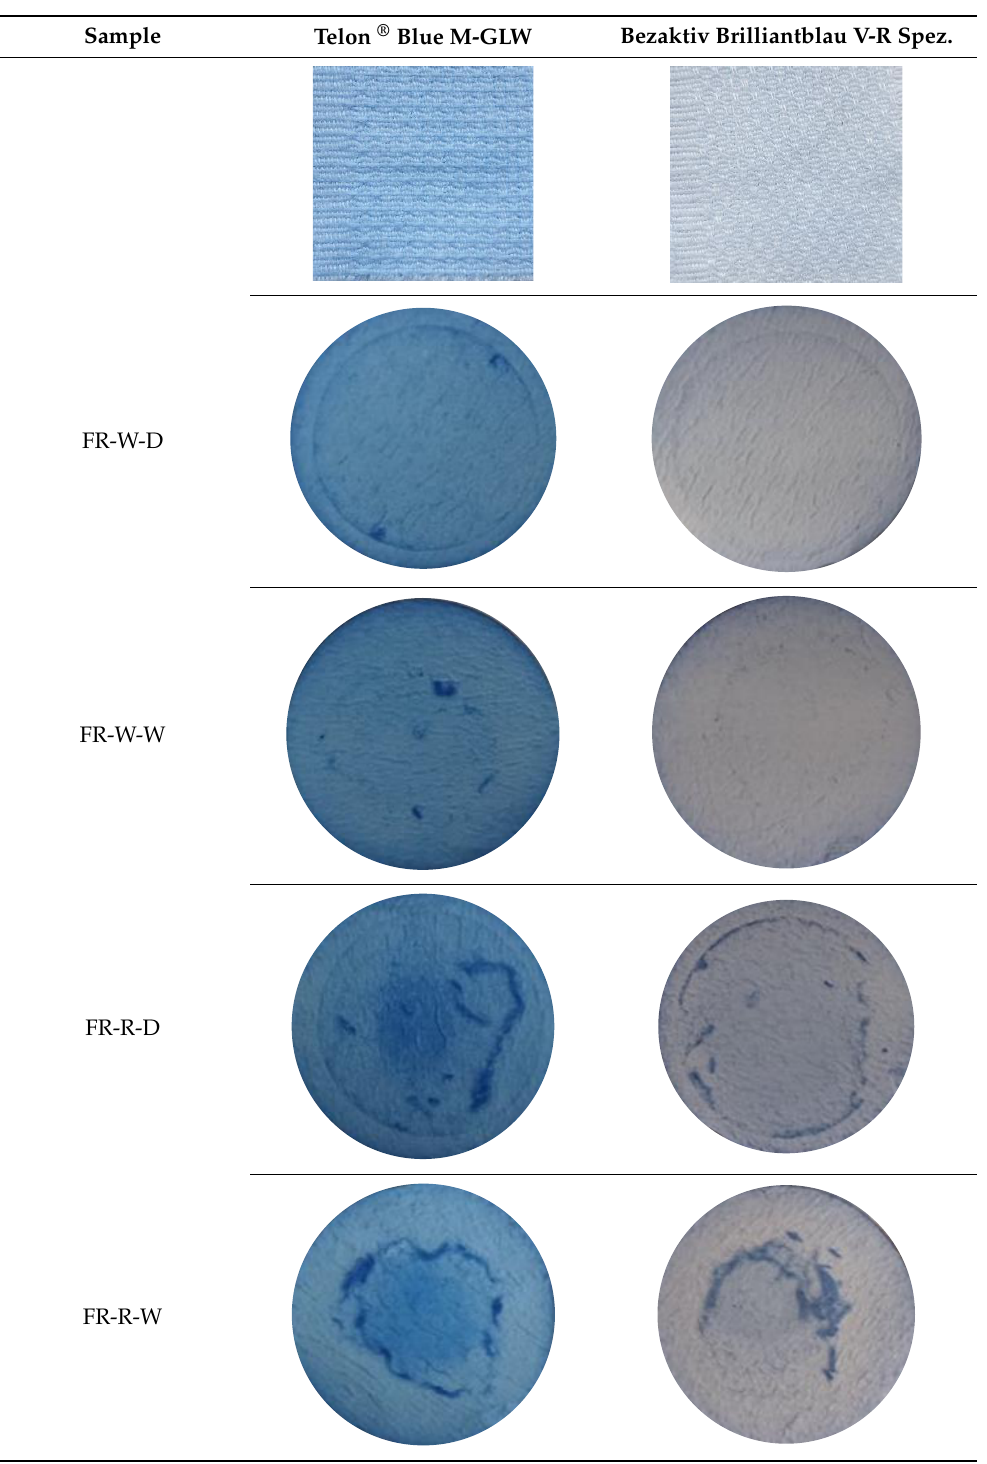
Table 3. Photo of the composite sample and FRs after the staining tests.